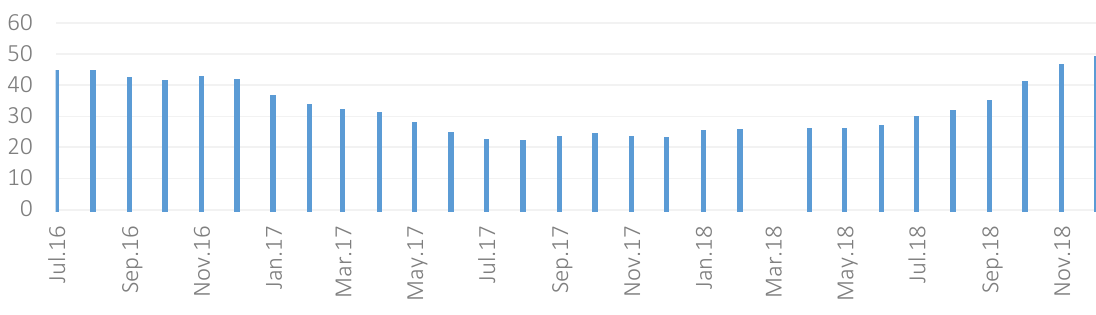
Figure 3. Annual inflation rate in Argentina during 2016–2018